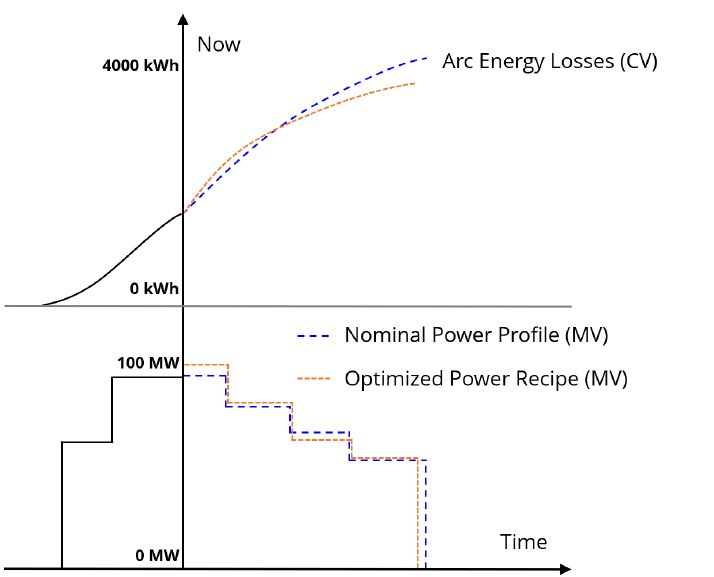
Figure 8. An illustration of MPC optimization for batch time and electric arc efficiency. Historical MV and model CV predictions are shown as solid black lines. Within the prediction horizon, optimized MV (MPC output) and CV are shown in orange, while nominal MV and the resulting CV are shown in blue.